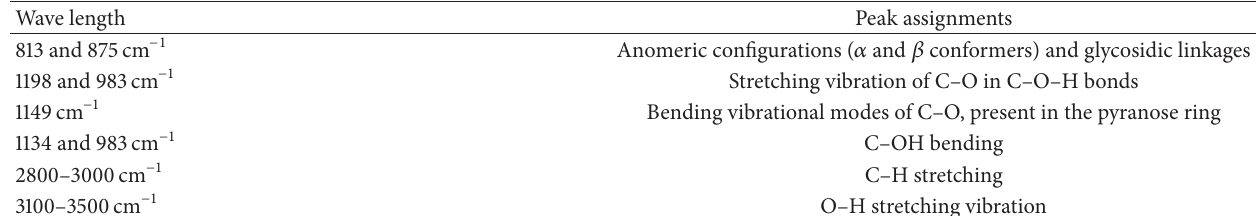
Table 3: Interpretation of FTIR data of polysaccharide.